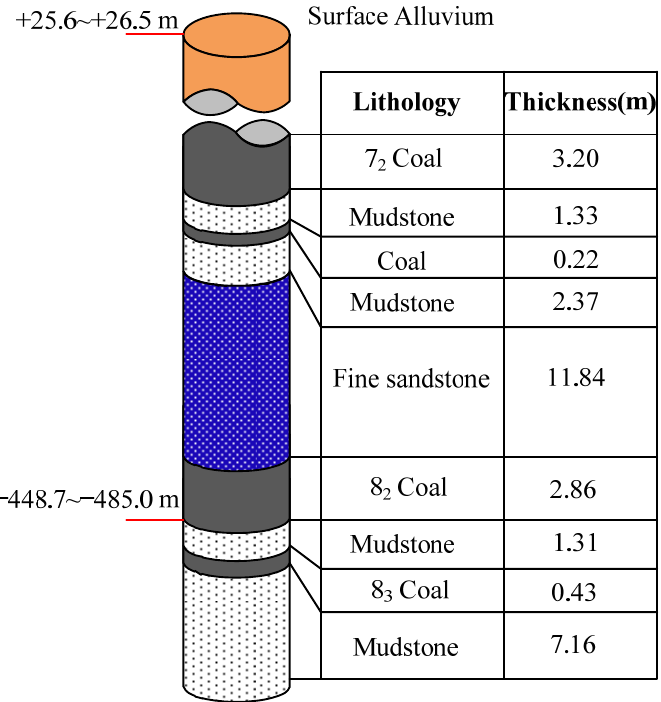
Figure 8. Location map of the 8 2 24-machine roadway in the XT Coal Mine.